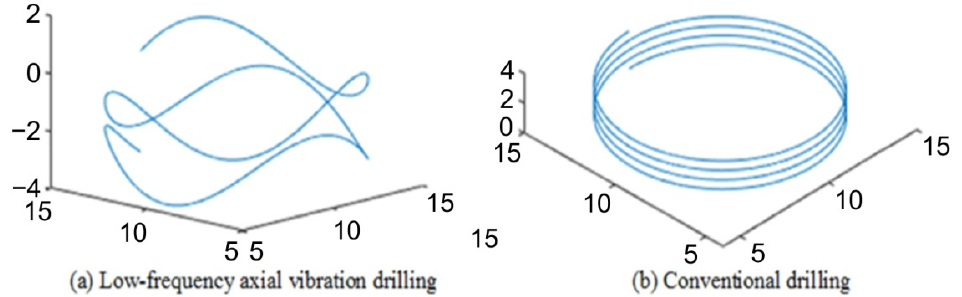
Figure 16. Schematic of point motion on the bit (Reprinted with permission from Ref. [147]. 2020, copyright Elsevier Ltd.).